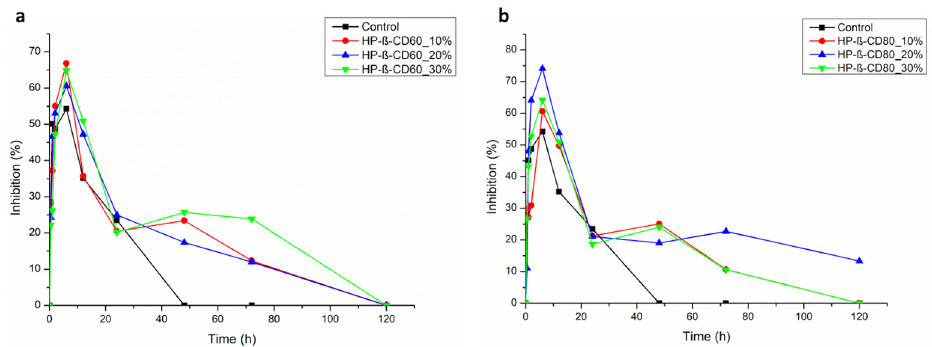
Figure 5. Time course of antioxidant activity of the films composed by ( a ) HP- β -CD60, ( b ) HP- β -CD80, and pectin.